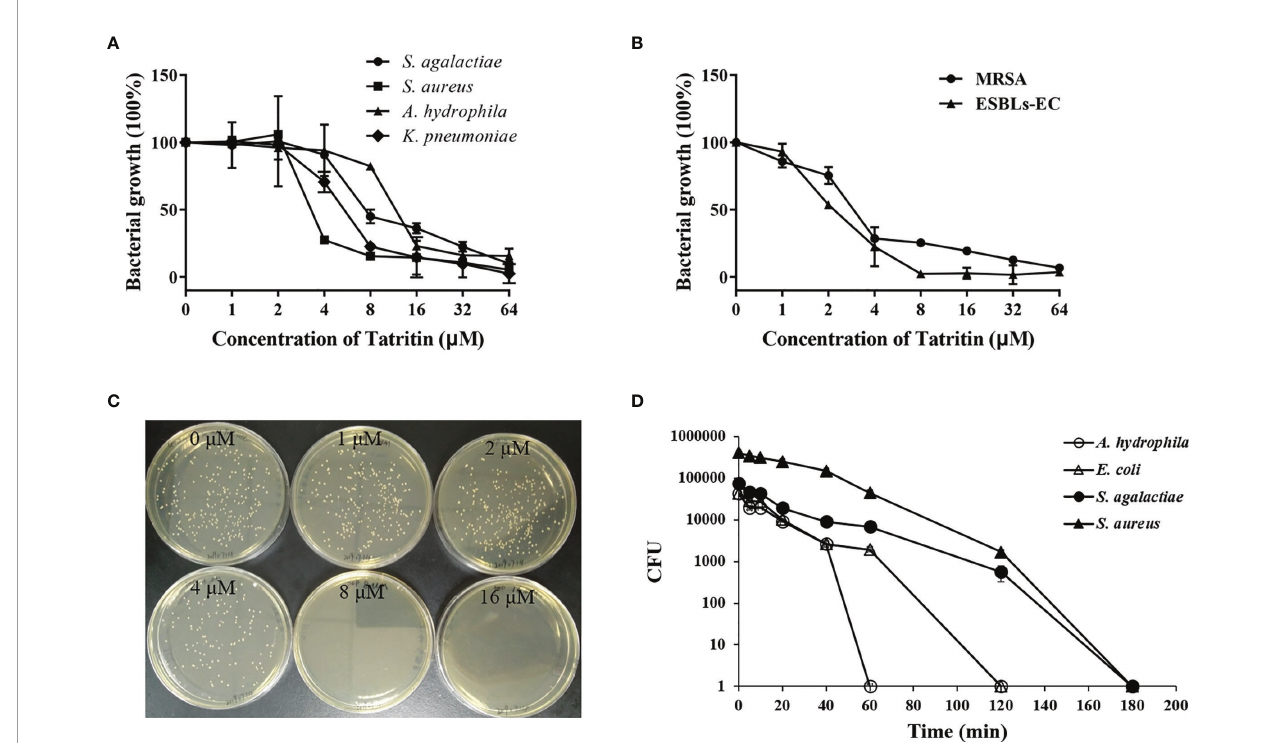
FIGURE 4 | Antimicrobial activities of Tatritin against S. aureus , S. agalactiae , A. hydrophila , K. pneumoniae , ESBLs-EC, MRSA, and C. albicans . Antibacterial activity of Tatritin peptide against Gram-positive, -negative bacteria (A) and drug-resistant bacteria (B) . The bacteria in the mid-logarithmic phase were diluted in medium and incubated with serially diluted peptide at a concentration of 10 5 CFU/ml for 18 h. OD 595 was measured and corrected by initial OD 595 values. Bacterial growth rates were calculated as the bacterial density in the presence of peptide to the bacterial density of controls. Data shown are the means of duplicate reactions in a representative of three independent experiments. (C) Antifungal activity of Tatritin peptide. Approximately 2 × 10 5 cells of C. albicans were mixed with Tatritin peptide diluted serially to 1, 2, 4, 8, and 16 m M. The minimum concentration in petri dish without colonies was regarded as the minimum fungicidal concentration.